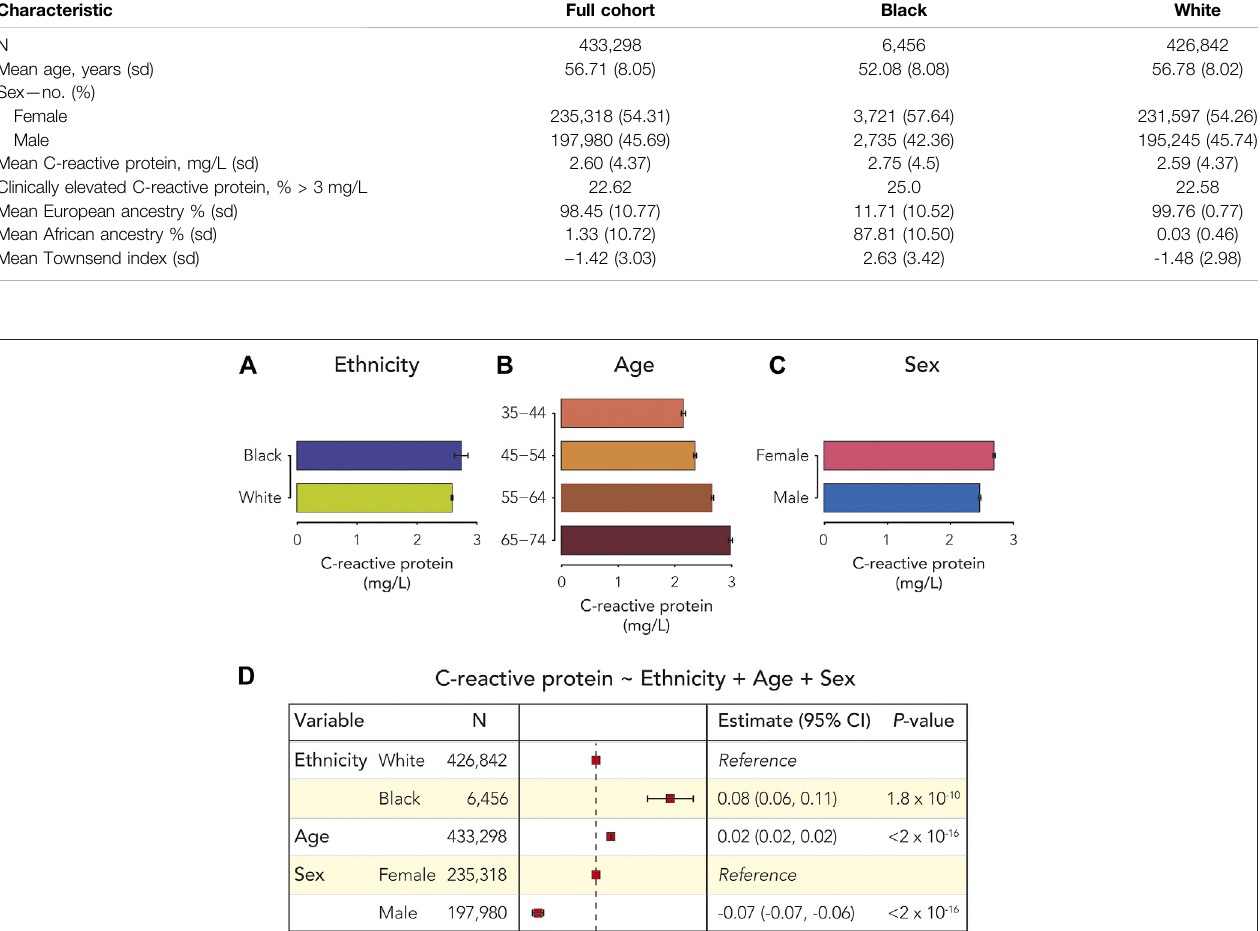
Table 6 ). The observed ethnicity-sex ( Figure 3A ). Principal components one and two separate interaction results from higher CRP for Black female participants compared to White female participants and lower